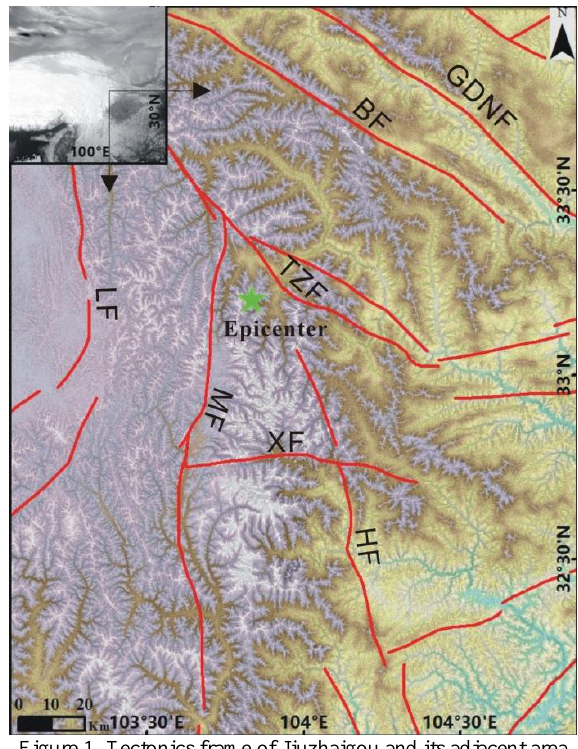
Figure 1. Tectonics frame of Jiuzhaigou and its adjacent area (Dai L X et al, 2017) (The green star denoted epicenter. The red lines denoted active faults. GDNF: Guanggaishan-Dieshan Northern Fault; BF: Bailongjiang Fault; TZF: Tazang Fault; LF: Longriba Fault; MF: Minjiang Fault; XF: Xueshanliangzi Fault; HF: Huya